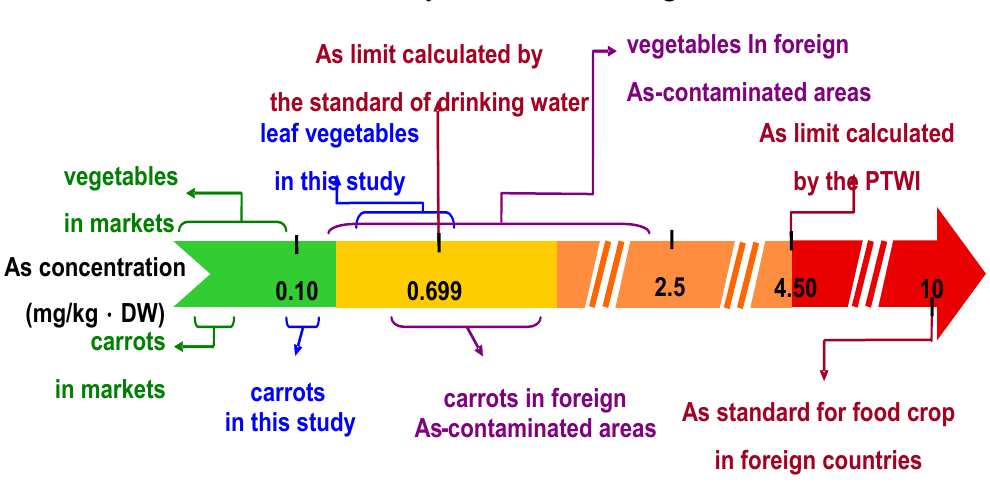
Figure 4. Summary of As concentrations in vegetable crops in this study, data in the literature, As limits calculated with the key indexes, and the regulation standard for